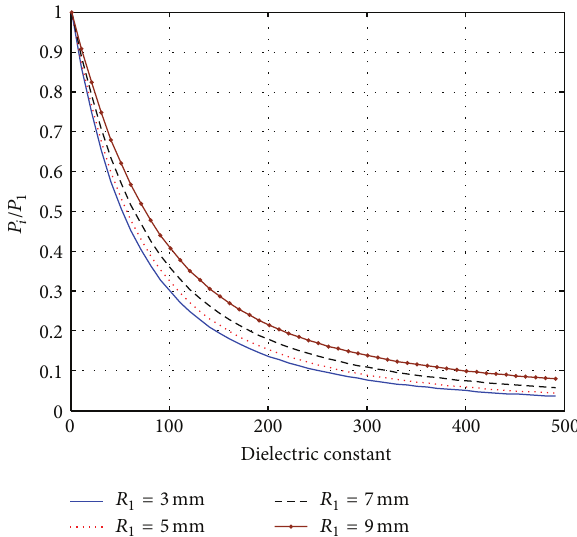
Figure 2: Normalized radiated power versus dielectric constant with small 𝑅 1 at 403 MHz.